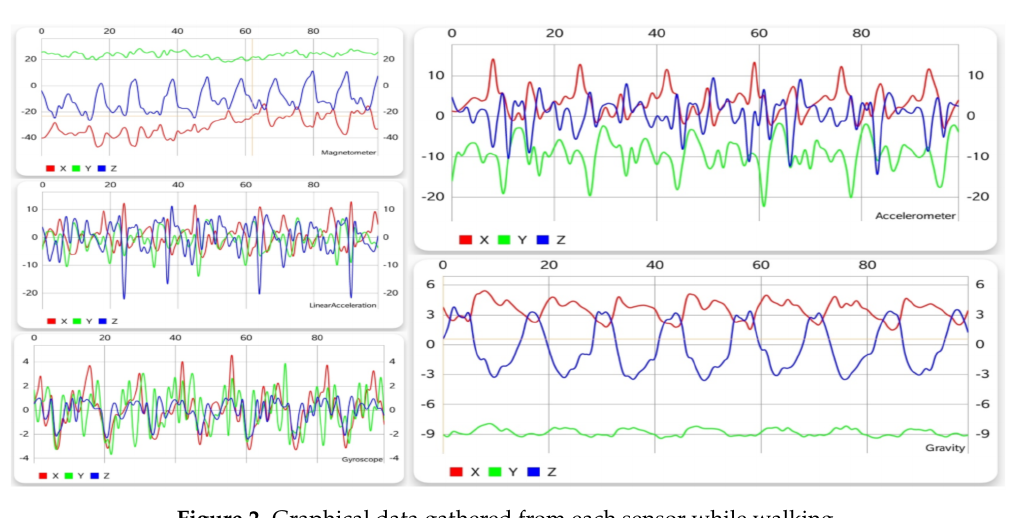
Figure 2. Graphical data gathered from each sensor while walking.